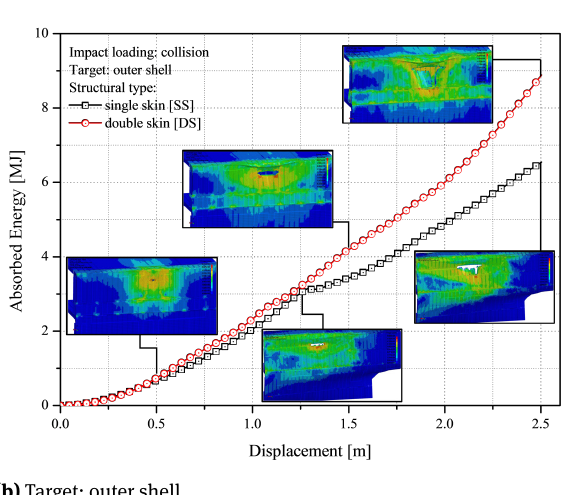
mancesagainstsidecollision,includingtheirmembers.As presented in Figure 4, it can be seen that the smooth